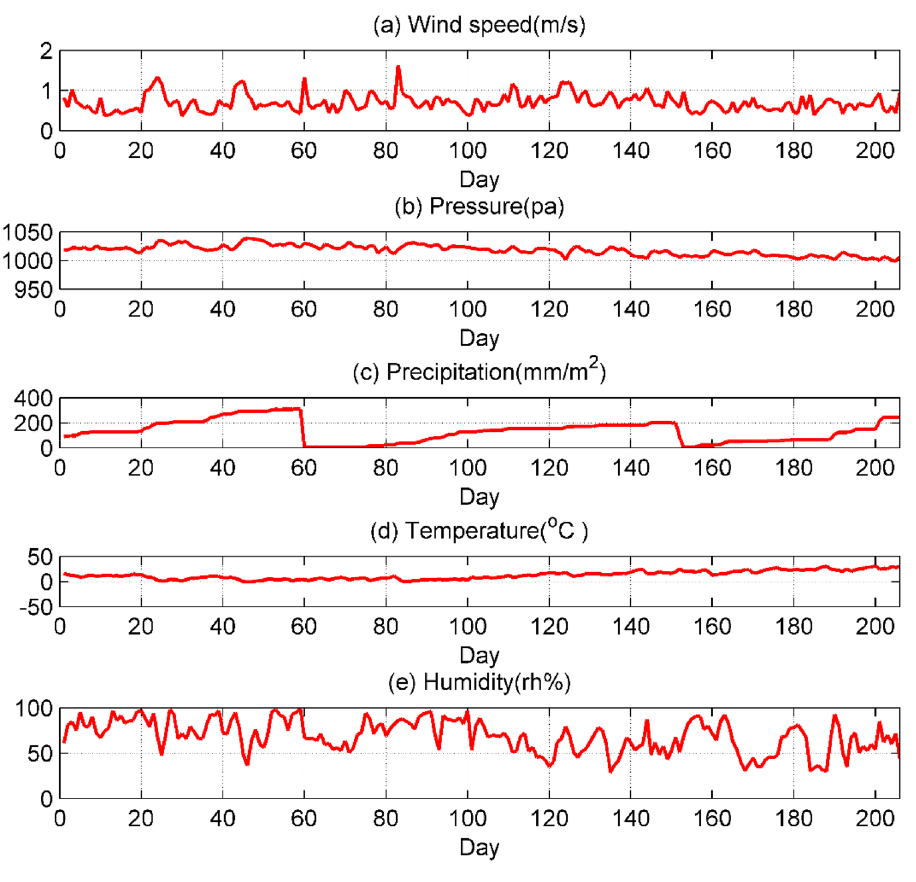
Figure 2. Variation of the daily average value of five meteorological